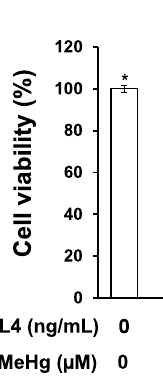
Figure 2. Effects of recombinant CCL2 or CCL4 on methylmercury-induced cytotoxicity in mouse primary cerebellar granule cells. Mouse primary cerebellar granule cells (neurons) (1 × 10 6 cells/mL) were cultured in Neurobasal A medium containing 2% B25, 1% FBS, and 25 mM KCl in 12-well plates for 2 weeks. Recombinant CCL2 ( A ) or CCL4 ( B ) was then added to the culture medium, and 1 h later cells were exposed to 5 μM methylmercuric chloride (MeHg) for 24 h. Cell viability was measured by the alamarBlue ® assay. Data are presented as the mean ± S.D. * p < 0.05; ** p < 0.01 compared with the “0 ng/mL recombinant chemokine, 5 µM MeHg group”.